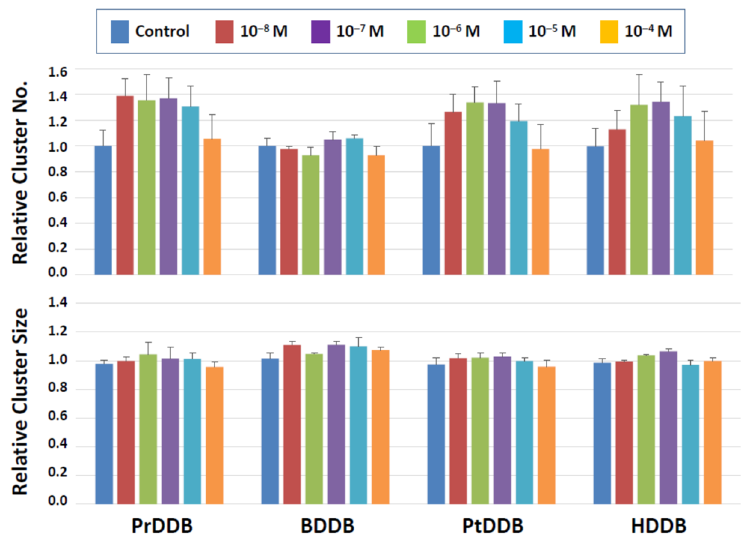
Figure 3. Cluster numbers and sizes after a 2-day exposure to dibenzoate derivatives (Figure 3). The data are normalized to the results of control (DMSO) treatment. No detrimental effects are detected on the cluster-forming activity in the presence of these two types of compounds.